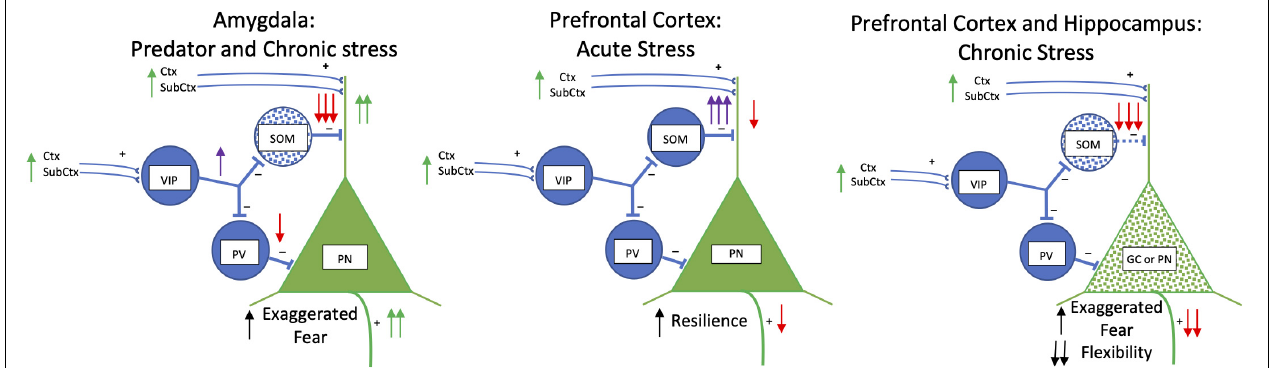
FIGURE 4 | Acute and Chronic Stress: Somatostatin. Simplified schematic drawing of the effects of acute and chronic stress on somatostatin. In the basolateral amygdala in the left panel, predator exposure and chronic stress produce a loss of somatostatin interneurons (blue stippling). This releases the glutamatergic principal neurons from strong dendritic inhibition and inhibition at the soma to increase activity of these neurons. This results in exaggerated fear. In the middle and right panels, the effects of acute and chronic stress in the medial prefrontal cortex and hippocampus are shown. With acute stress there are increases in activity and hyper-inhibition in somatostatin interneurons in the medial prefrontal cortex which strongly inhibits dendritic activity and produces resilience to stress. With chronic stress somatostatin interneurons die (blue stippling) in both medial prefrontal cortex and hippocampus. What results are dendritic retraction and loss of spines in principal and granule cells (green stippling) creating exaggerated fear and loss in cognitive flexibility. Abbreviations are the same as in Figure 2